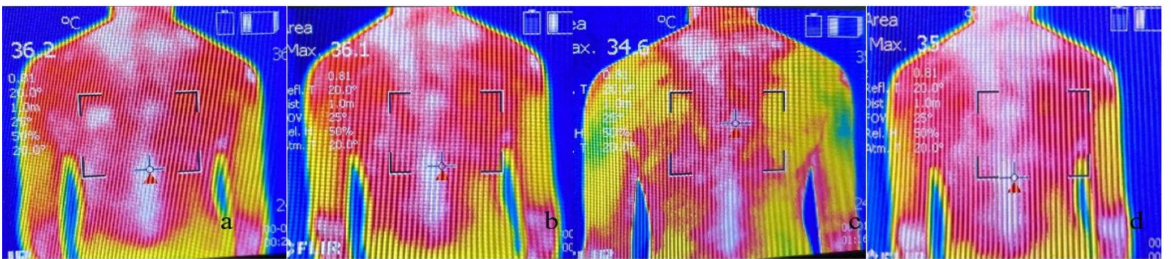
Figure 7. Subject with scoliosis 3 ( a ) image taken at the beginning; ( b ) image taken at the end of exercise 1; ( c ) image taken at the end of exercise 2; ( d ) image taken at the end of exercise